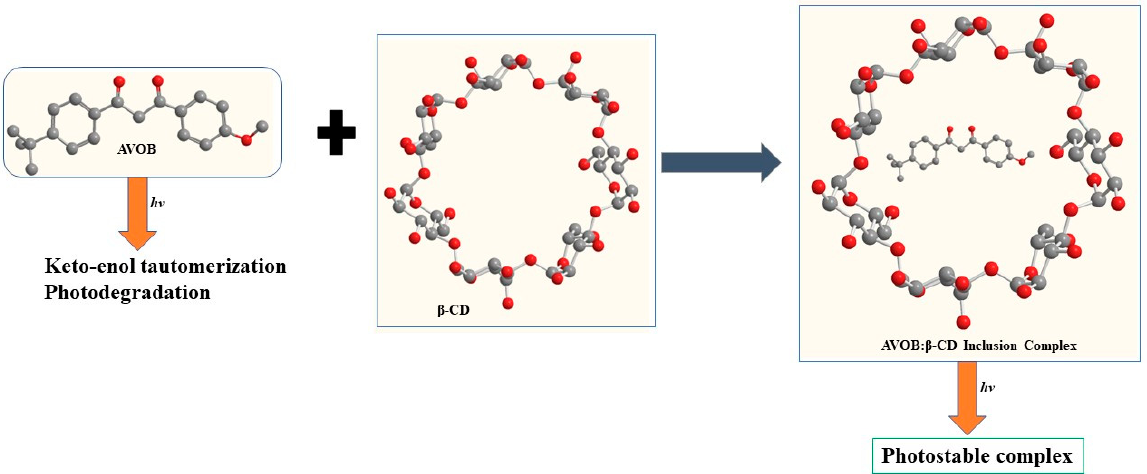
Figure 5. Avobenzone & β Cyclodextrin Inclusion Complex. AVOB undergoes photodegradation through keto-enol tautomerism to produce photodegraded products, which further induces photo- toxicity. Such issues are countered by effective encapsulation by β -cyclodextrin by forming an avo- benzone photostable comp.